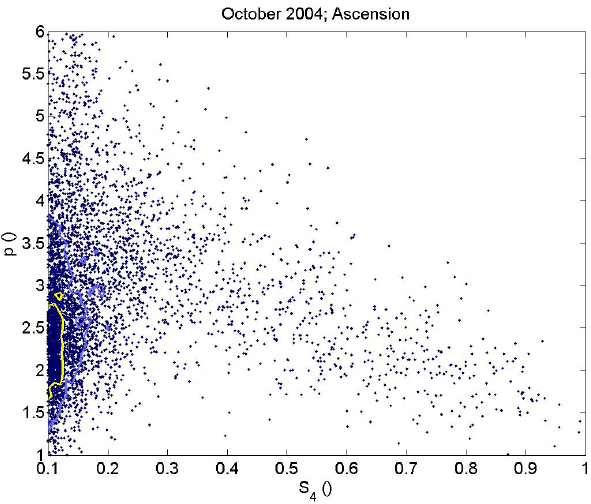
Fig. 8. The median spectral index p in Ascension and Vanimo as functions of the hour of the